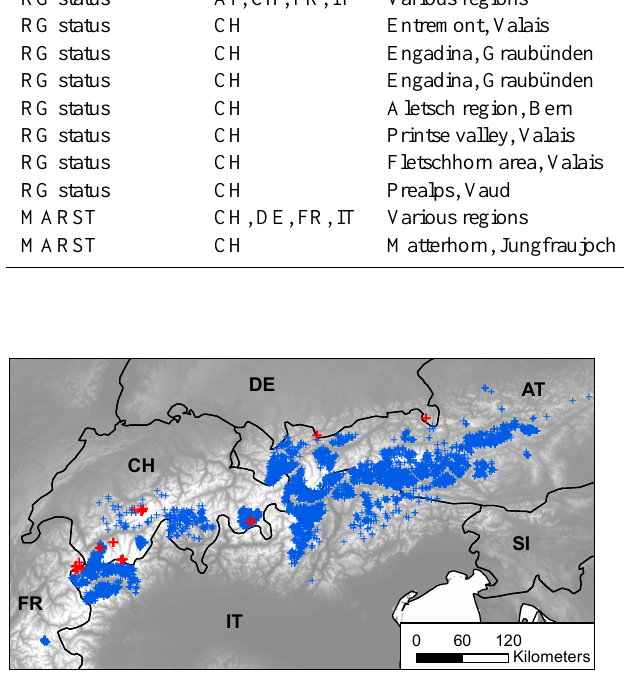
Fig. 1. Spatial distribution of intact/relict rock glaciers (blue crosses) and the locations of the rock surface temperature loggers (red